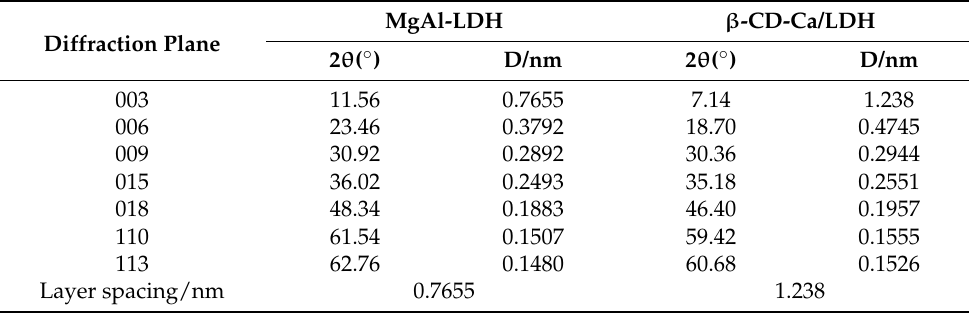
Table 2. Lattice parameters of MgAl-LDH and β -CD-Ca/LDH.